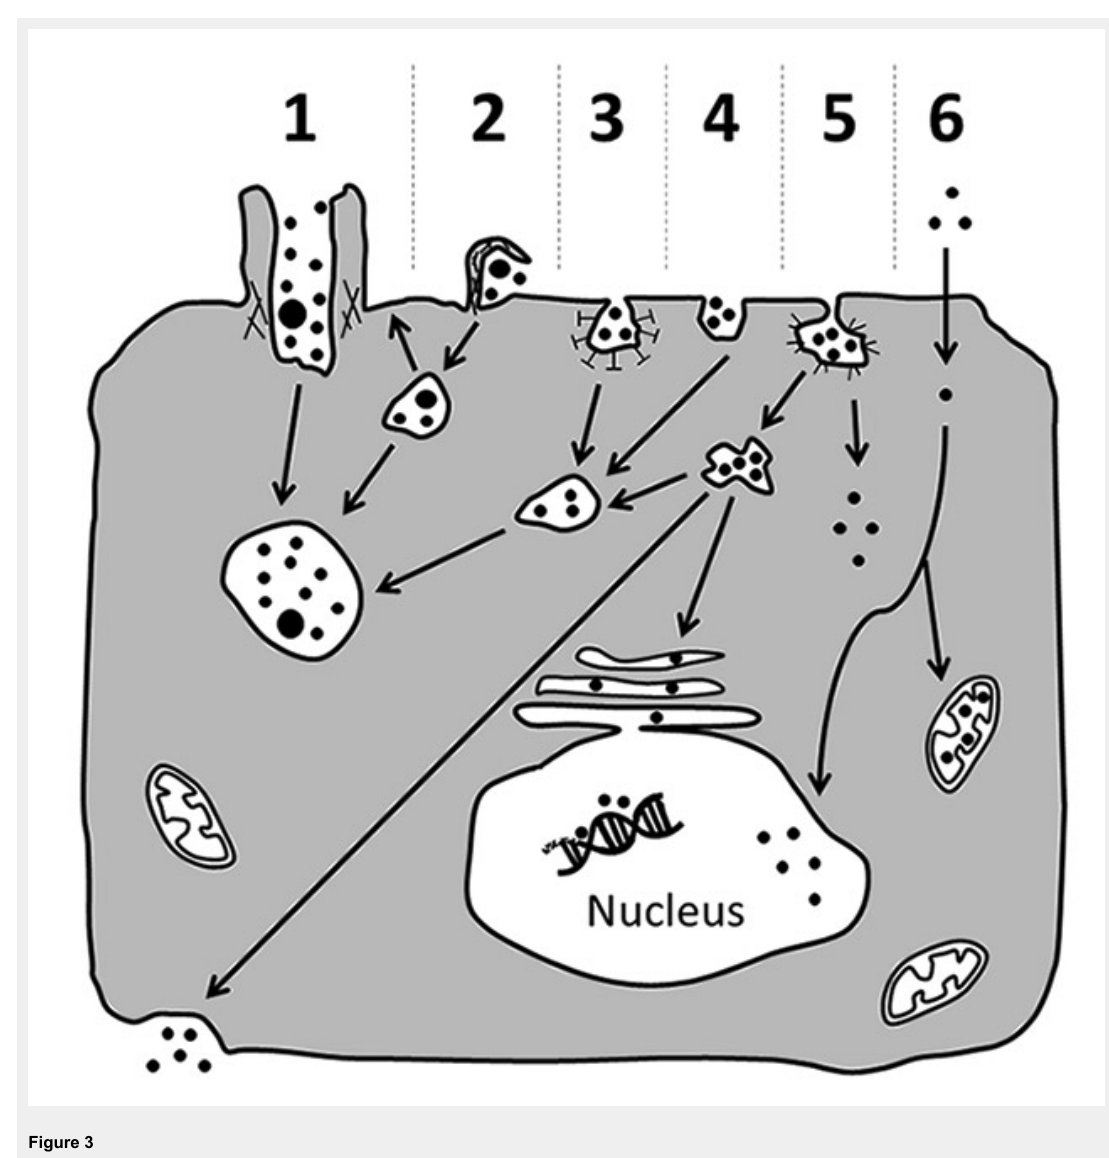
Possible mechanisms for cellular uptake of nanomaterials and their subsequent intracellular trafficking. Nanomaterials may be actively incorporated via phagocytosis (1), macropinocytosis (2), clathrin-dependent endocytosis (3), clathrin- and caveolae-independent endocytosis (4) or caveolae-mediated endocytosis (5). Particles that were internalised via active uptake are commonly transported in vesicular structures that then fuse to phagolysosomes or endosomes (1–5). Sometimes, they might be exocytosed upon macropinocytosis (2). Alternatively, they may also be carried to the cytosol, or be transported via caveosomes to the endoplasmic reticulum, or cross the cell as part of transcytotic processes (5). Besides active transport, nanoparticles may also enter the cell passively via diffusion through the plasma membrane (6). From the cytoplasm they may then gain access to subcellular compartments such as the nucleus and mitochondria (6). However, further research is needed to clarify if a particular entering mechanism or a certain intracellular localisation elicit specific cellular responses. Figure and figure legend have been modified from reference